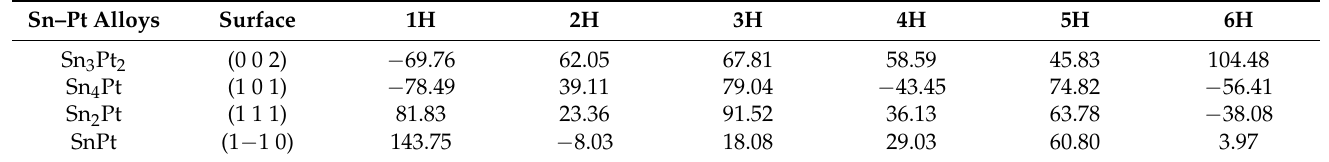
Table 2. Calculated energy for the removal of a half hydrogen molecule (1/2H 2(g) ) up to the sixth hydrogen atom (3 H 2(g) ) on the different surfaces considered for the Sn–Pt alloys.